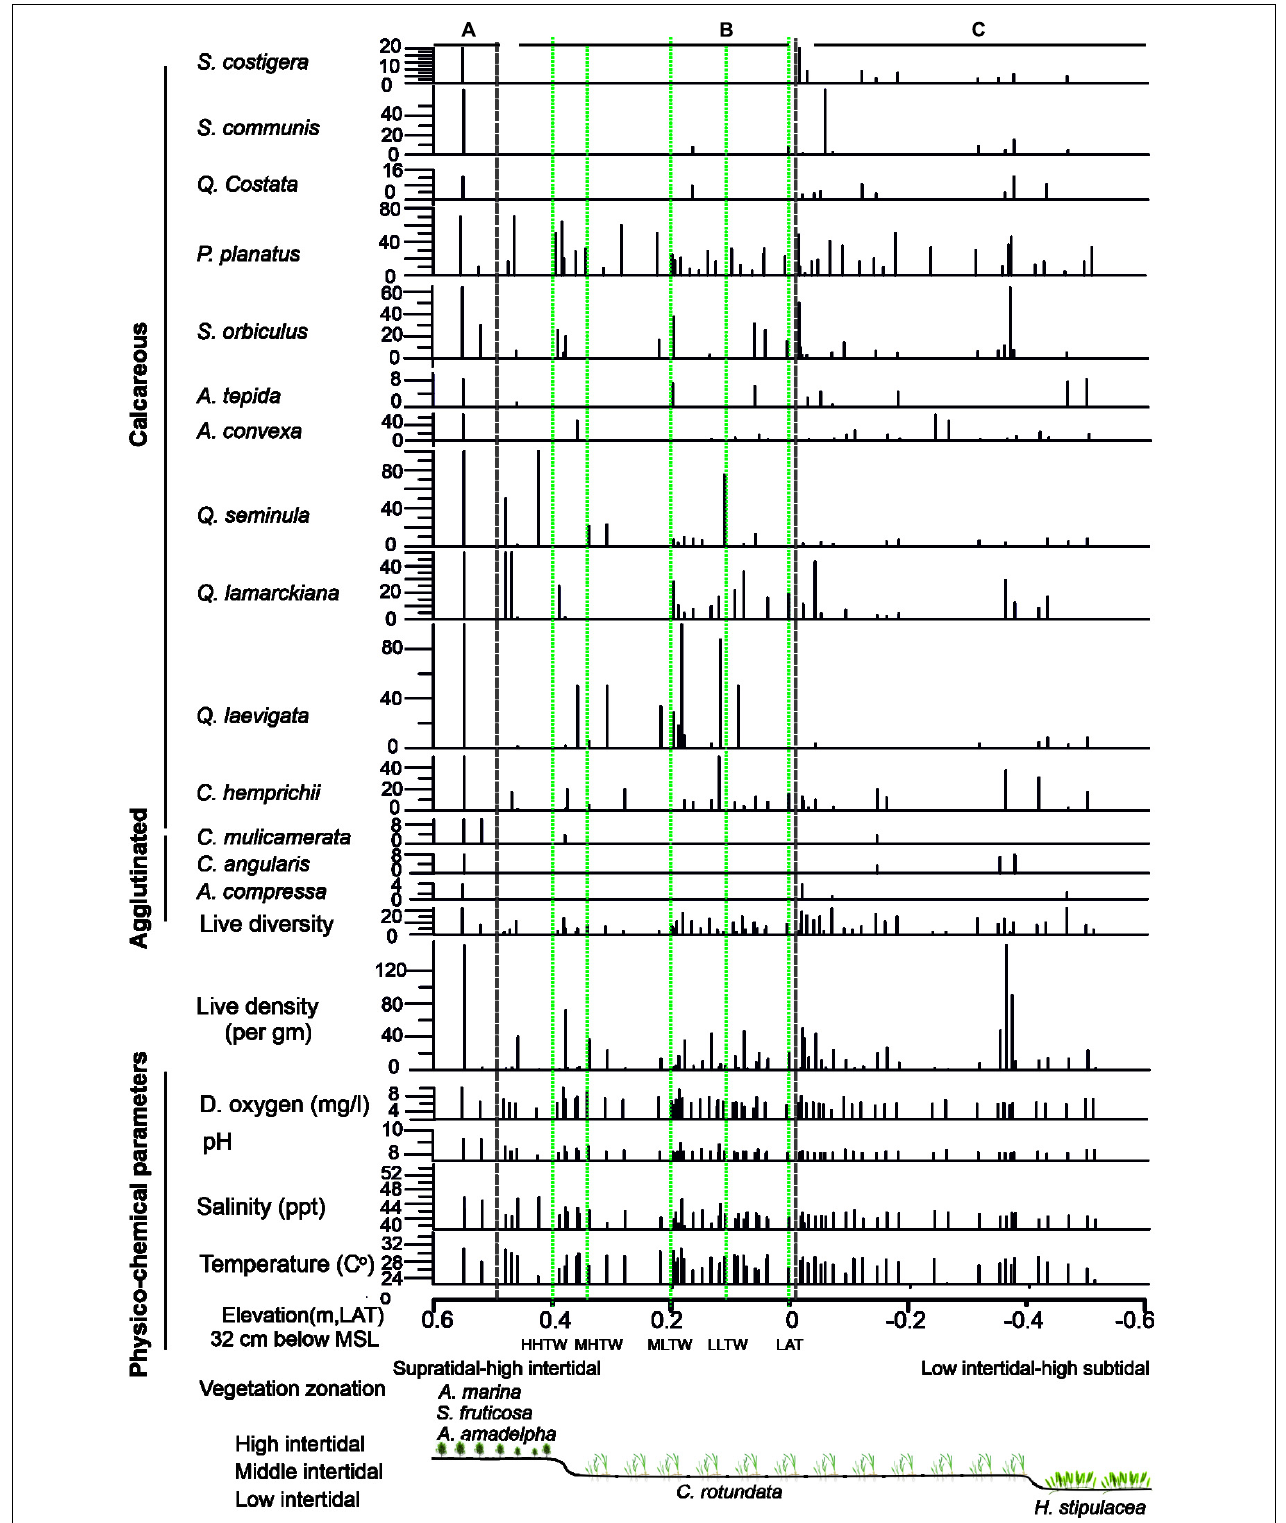
FIGURE 7 | A frequency histogram of the distribution of live benthic foraminifers across intertidal sabkha vs. the elevation (m, LAT) of the Al-Kharrar Lagoon during March 2014. Vegetation zonations based on elevations.